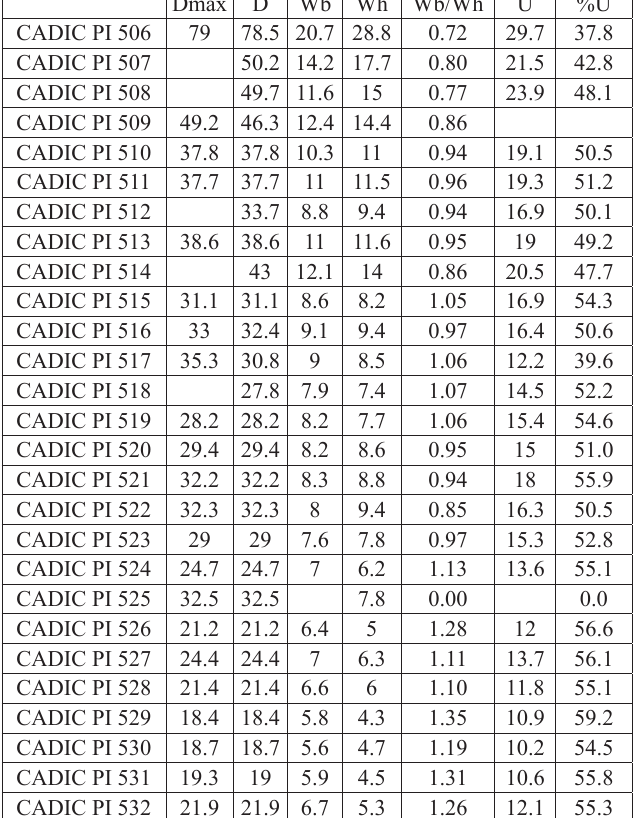
Fig. 9. The gaudryceratid ammonoid Anagaudryceras , from early Cam- pa nian − Maastrichtian (Cretaceous), Antarctica, Rabot Formation, Punta Redonda (A, H–J), Snow Hill Island Formation, Sanctuary Cliffs (B–G), and López de Bertodano Formation, Seymour Island (K). A . Anagaudryceras calabozoi Raffi and Olivero sp. nov., CADIC PI 486, neanoconch, the ar- row marks the last rib of the neanoconch. B – F . Anagaudryceras subcom- pressum Raffi and Olivero sp. nov. B . CADIC PI 508, phragmocone and part of the body chamber, in lateral (B 1 ) and ventral (B 2 ) views. C . CADIC PI 506, holotype, phragmocone and part of the body chamber, in lateral